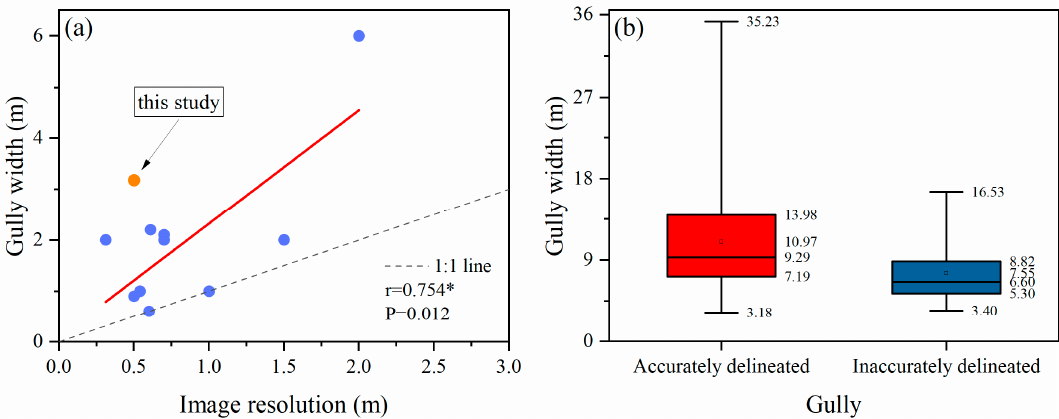
Figure 6. ( a ) The relationship between image resolution and minimal identifiable gully width, which were collected from following literature: [3,11,26,30,35,39,41,62–64]. ( b ) The width range of gullies that were accurately and inaccurately delineated from Pleiades image, respectively, which were divided according to the standard determined in Section 4.1.